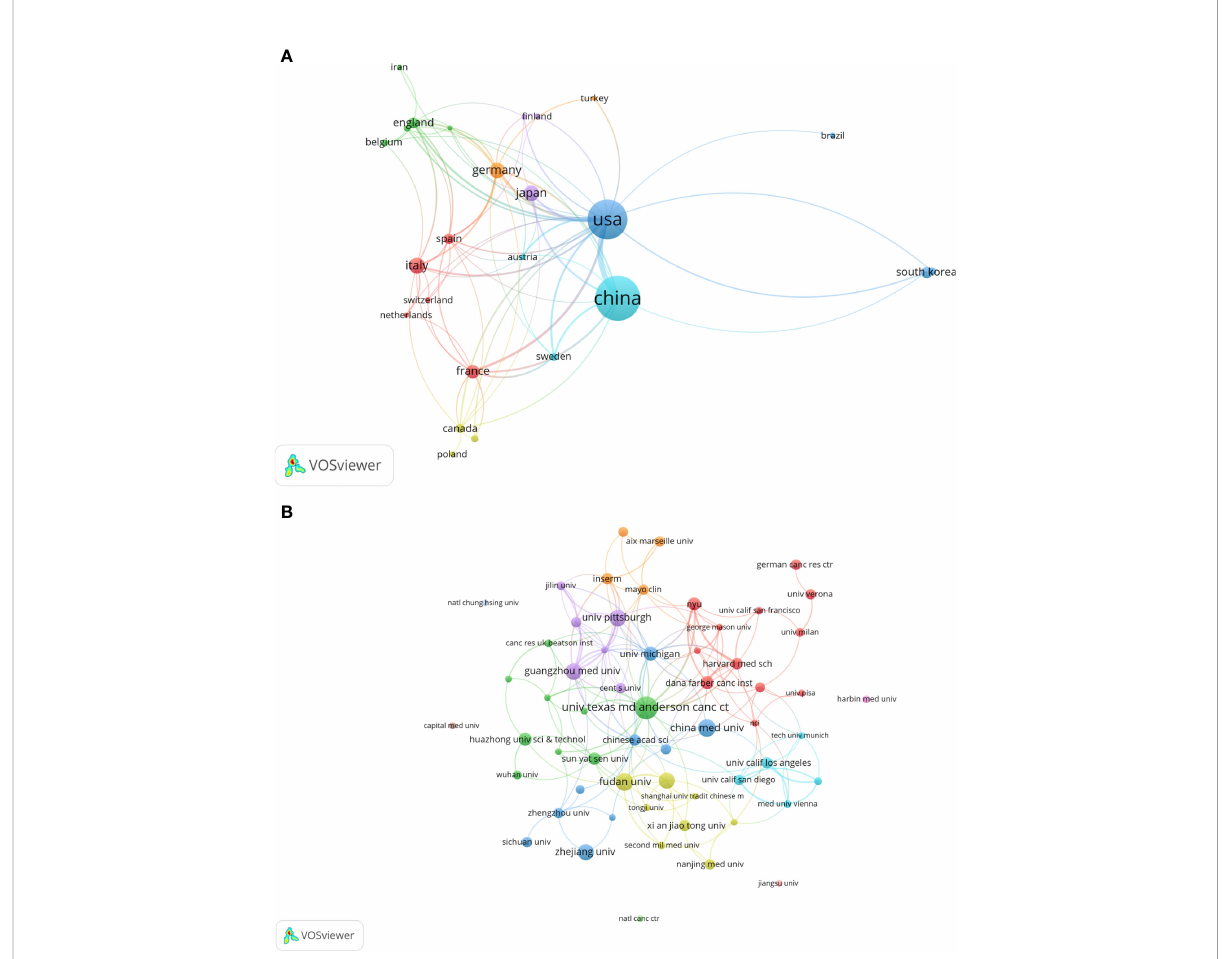
FIGURE 3 A visual map for VOSviewer network of countries and organizations related to autophagy of pancreatic cancer. (A) Country cooperation analysis. The total link strength was 241; the layout parameters: Attraction: 2, Repulsion: 1; (B) Organization cooperation analysis. The total link strength was 266; the layout parameters: Attraction: 4, Repulsion: -1. The circle size means the number of publications; the thickness of the line means the strength of the